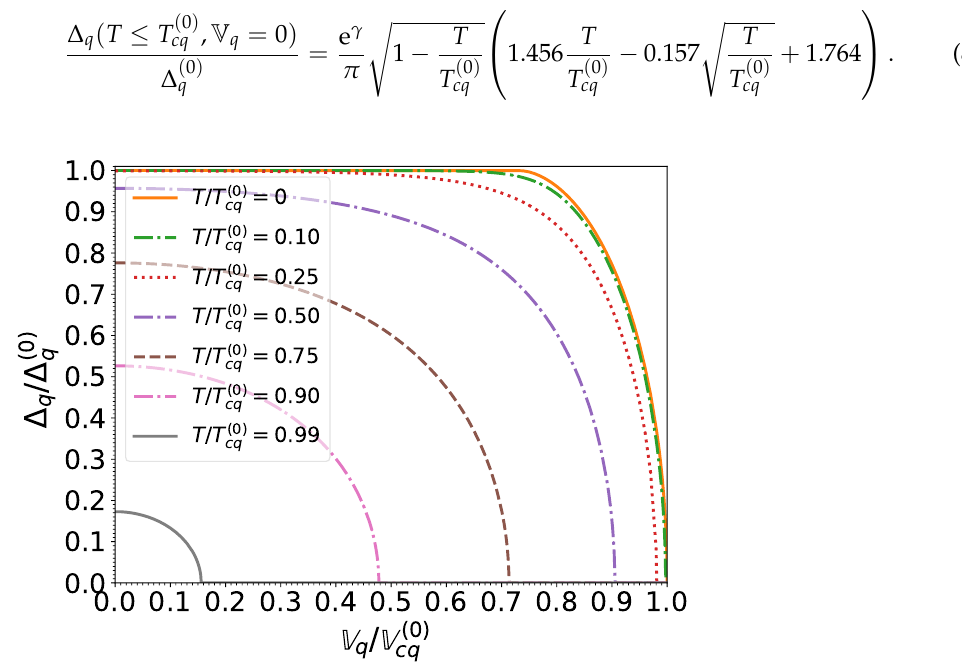
Figure 3. 1 S 0 nucleon pairing gap relative to that at zero temperature and in the absence of super- flow, as a function of the normalized effective superfluid velocity V q / V ( 0 ) temperatures T / T cq .